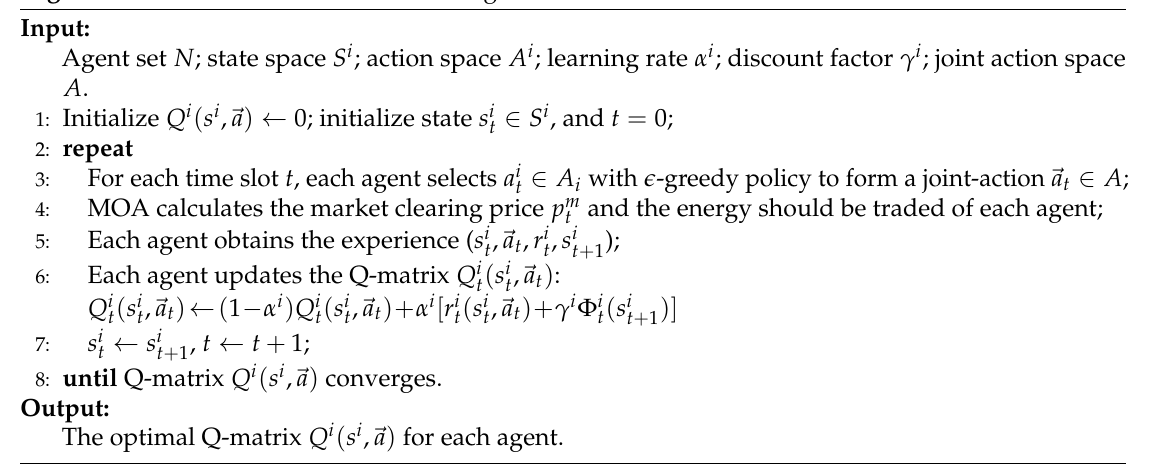
Algorithm 1 General Framework of Microgrid